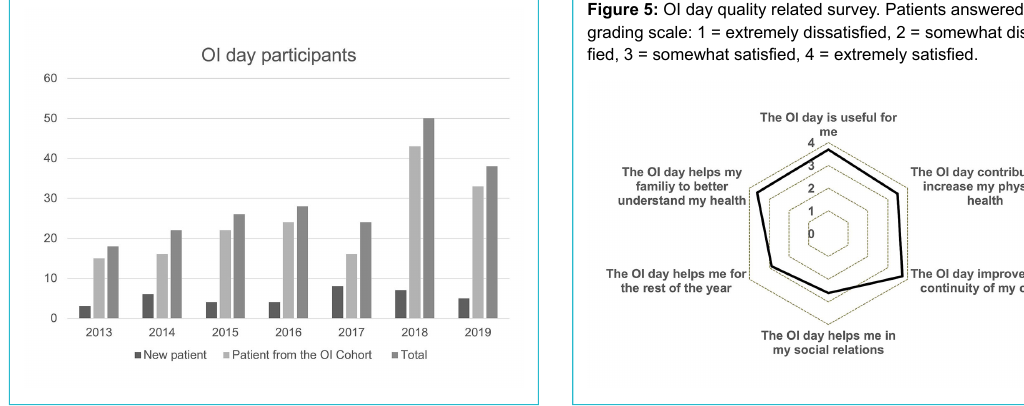
Figure 4: Patient attendance at OI days . OI = osteogenesis imper- fecta